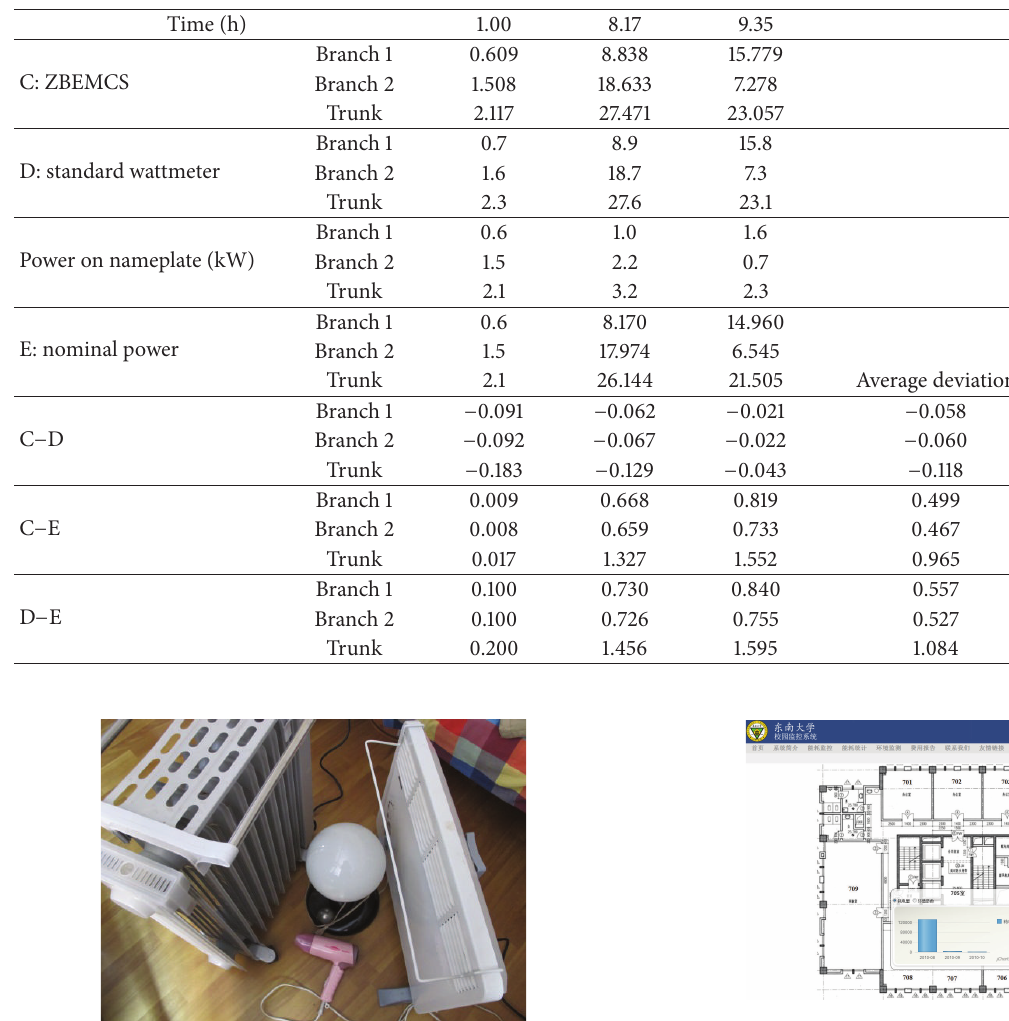
Figure 14: Floor plan of the seventh floor of the RRSAB. Table 4: The facilities in the testing